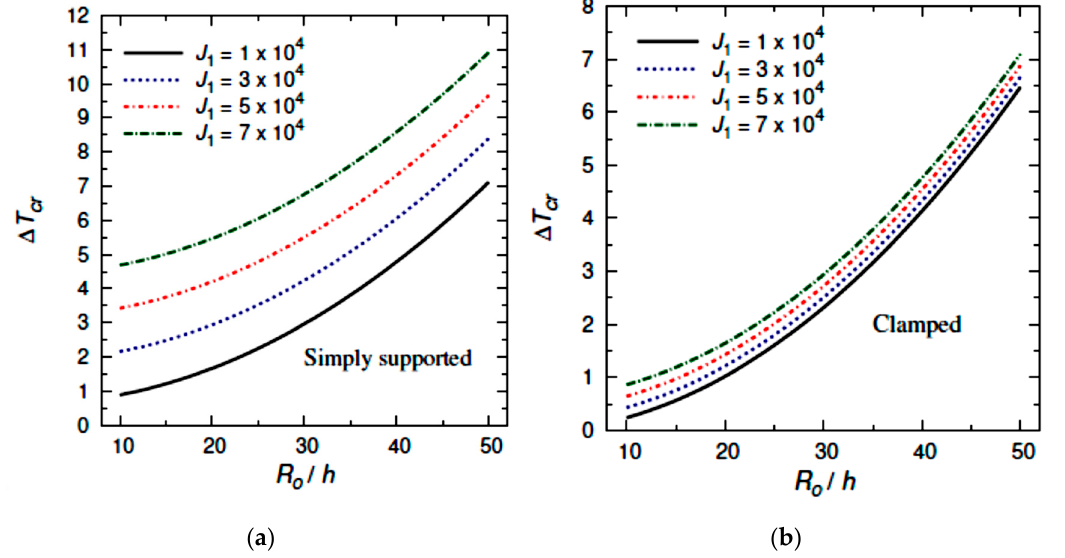
Figure 6. Effects of the Winkler coefficient 𝐽 (cid:2869) on the critical buckling temperature Δ𝑇 (cid:3030)(cid:3045) of ( a ) simply supported and ( b ) clamped SGP annular plates ( 𝑅 (cid:3036) /𝑅 (cid:3042) = 0.3 , 𝜅 = 1 , 𝐸 (cid:3085) = 10 (cid:2871) V/m , Δ𝐶 = 0.5% , 𝑒 (cid:2868) = 10 , 𝑤 (cid:3034) = 0.1% , 𝜇 = 𝛾 = 2 nm , 𝐽 (cid:2870) = 10 ).